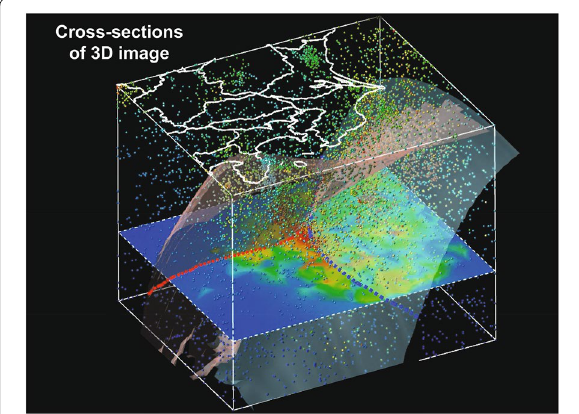
Fig. 3 Colored particles at the 3D Delaunay tessellation vertices, which were derived from all earthquakes of M 4 and additionally ≥ located points. The top surface, with map features, corresponds to that of Fig. 1b. The depth scale is exaggerated. The colors indicate either snapshots of predicted occurrence rates, from Eq. (3) at some time t , or inverted solutions of location-dependent parameters of the Eq. 4 space–time